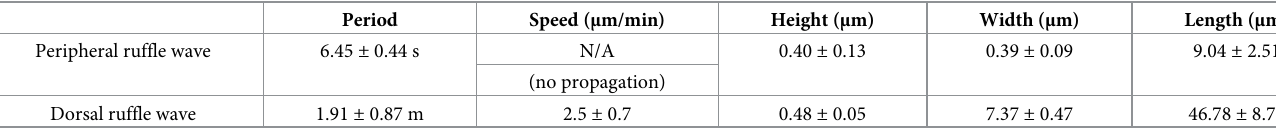
Table 1. The properties of the peripheral ruffle waves and dorsal